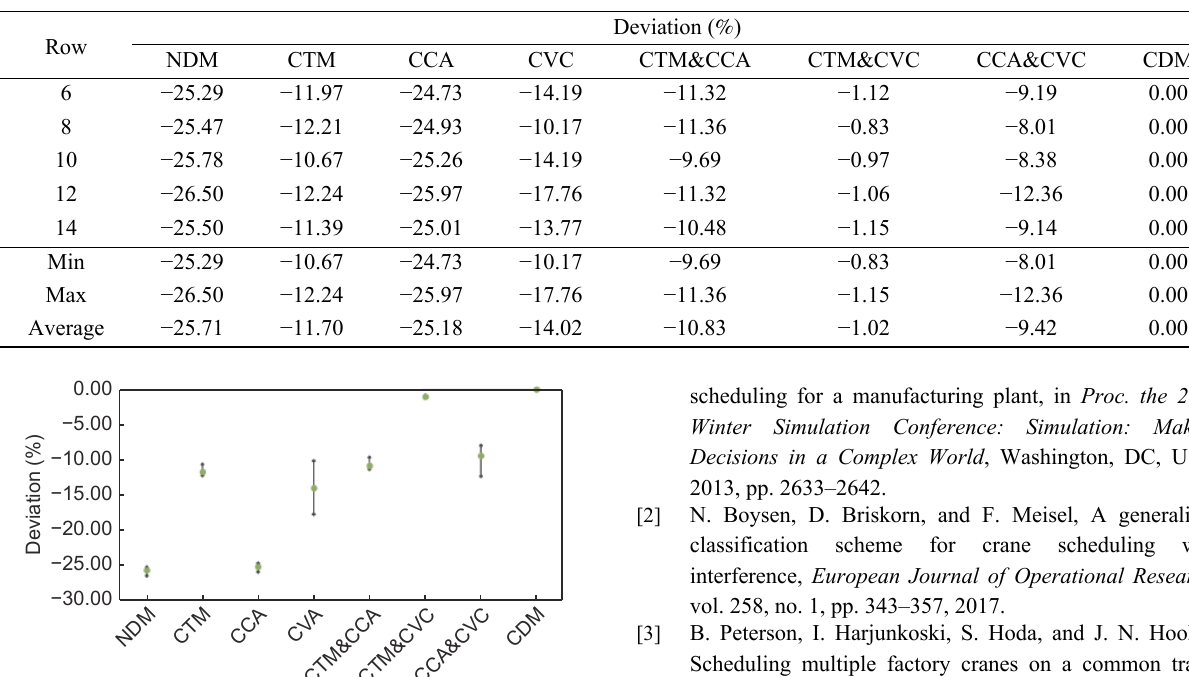
Table 7 Statistics table of deviations in different row numbers (column = 40).